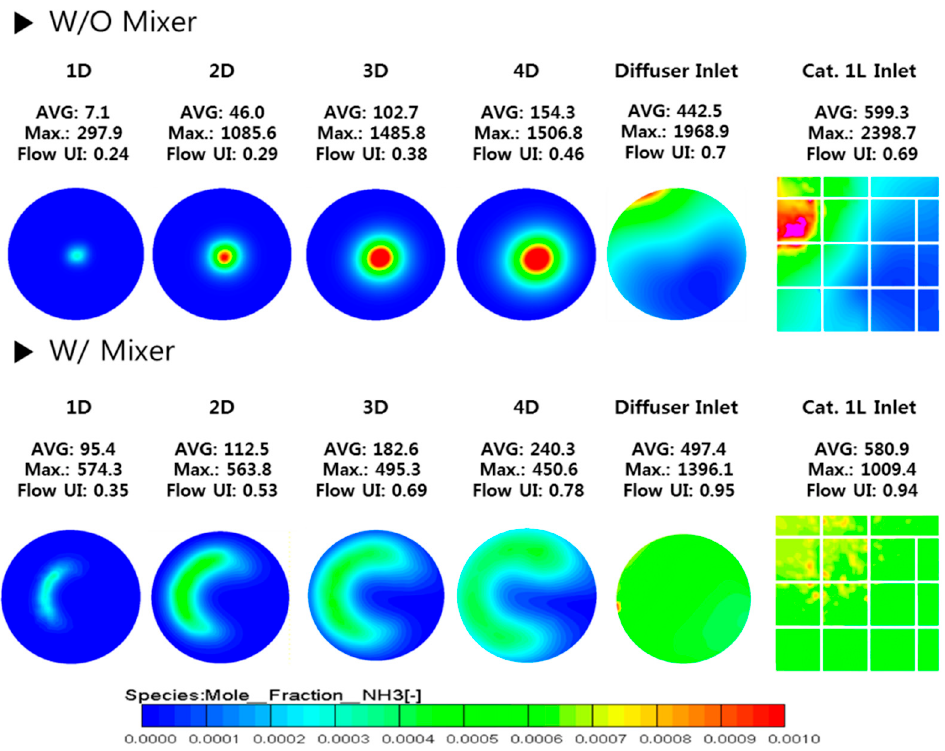
Figure 7. NH 3 distribution at specific locations with and without mixer.